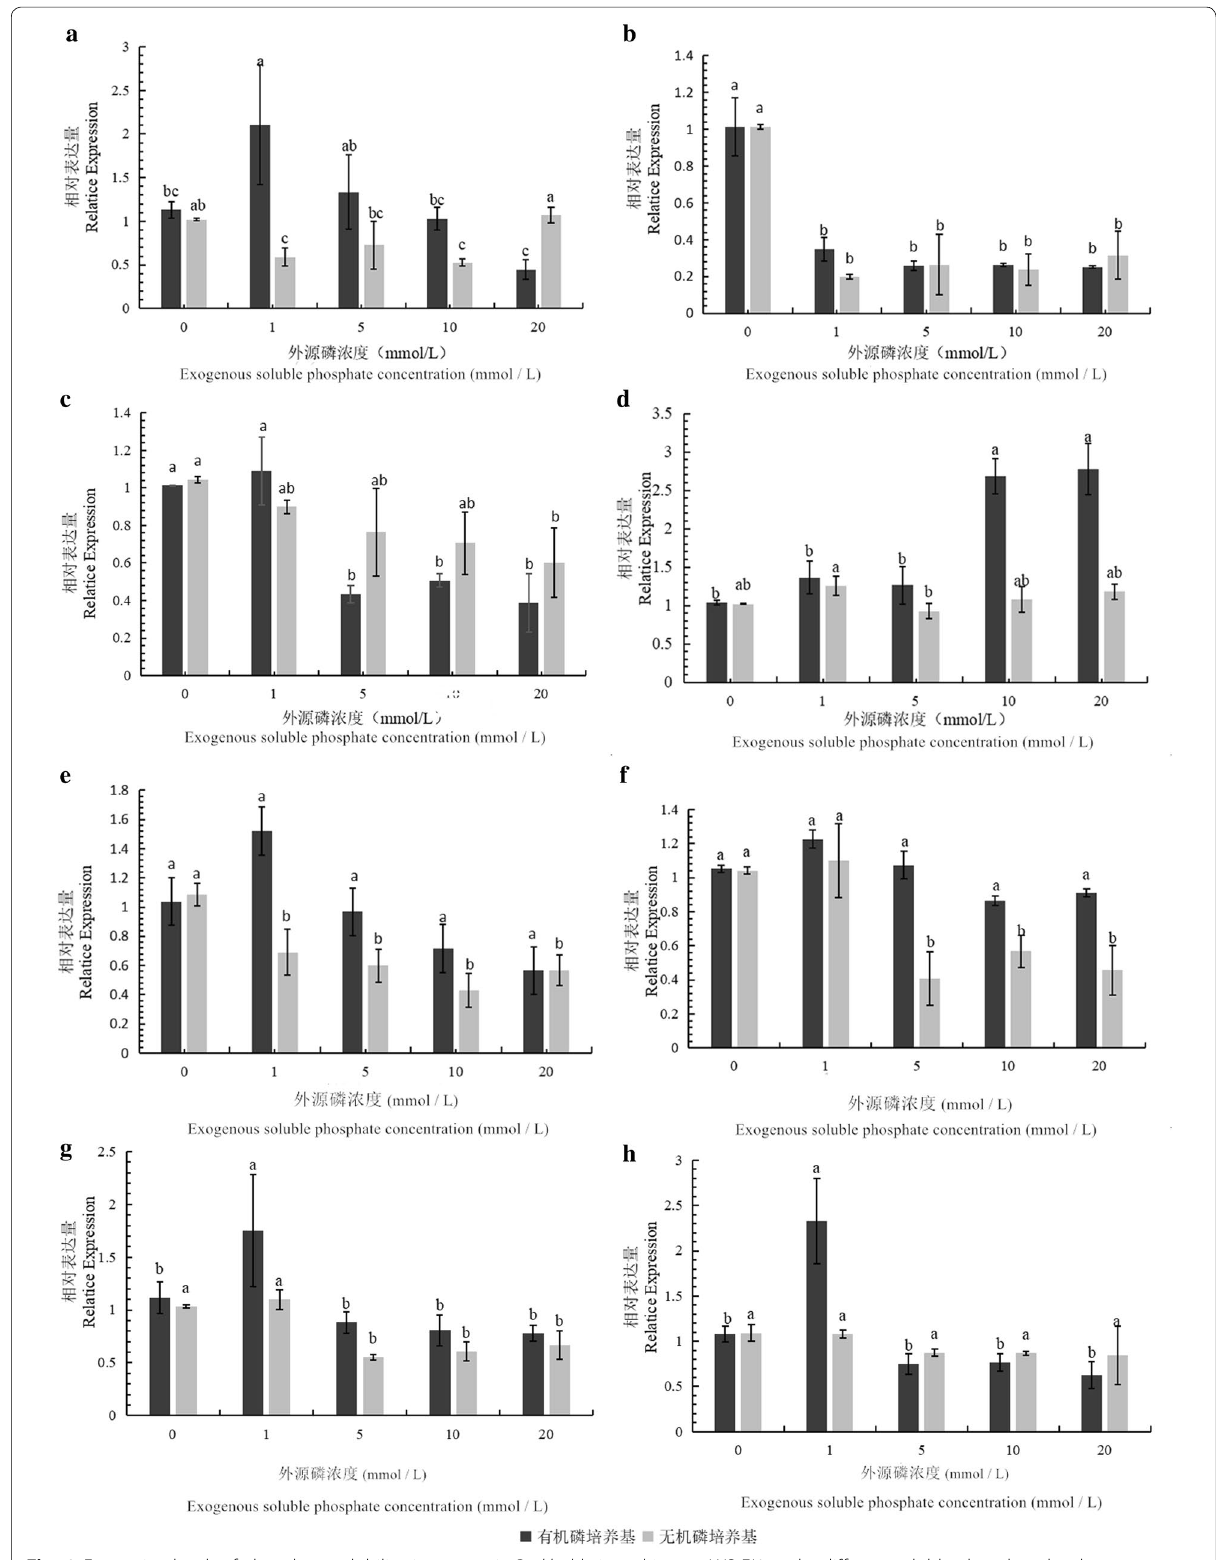
Fig. 6 Expression levels of phosphate solubilization genes in Burkholderia multivorans WS‑FJ9 under different soluble phosphate levels. a gene PhoA ; b gene PhoR ; c gene AP ‑ 1 ; d gene AP ‑ 2 ; e gene AP ‑ 3 ; f gene HlyB ; g gene GspE ; h gene